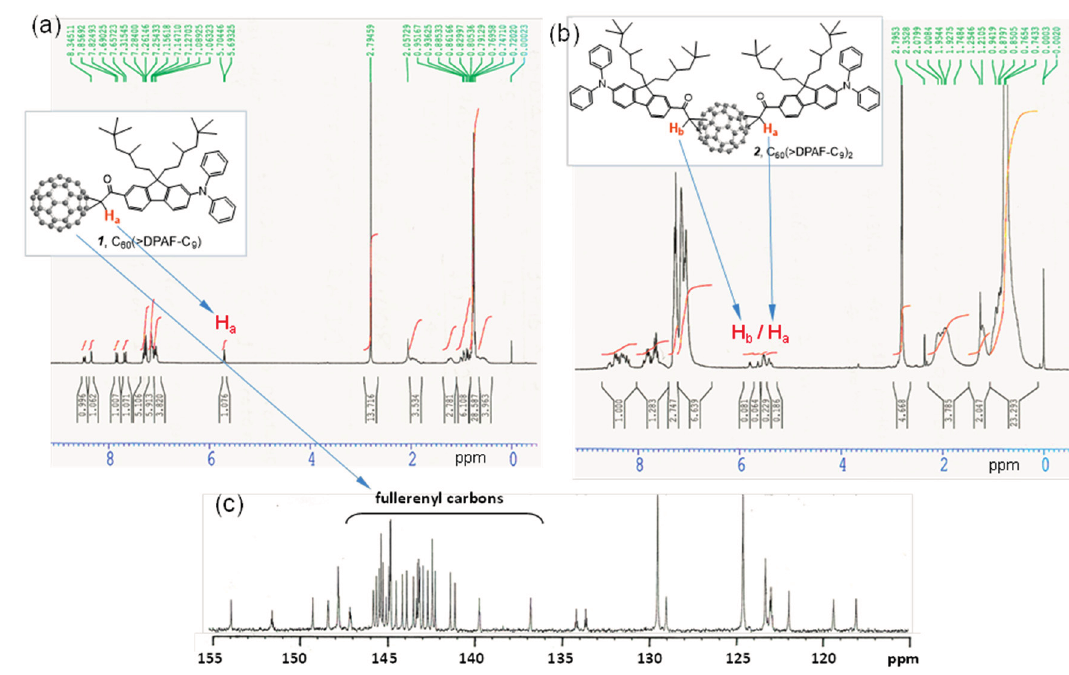
Figure 2. 1 H-NMR spectra of ( a ) the monoadduct C 60 (>DPAF-C 9 ) 1 and ( b ) the bisadduct C 60 (>DPAF-C 9 ) 2 2 . Chemical shift of the H a proton of 1 was used to assign H a and H